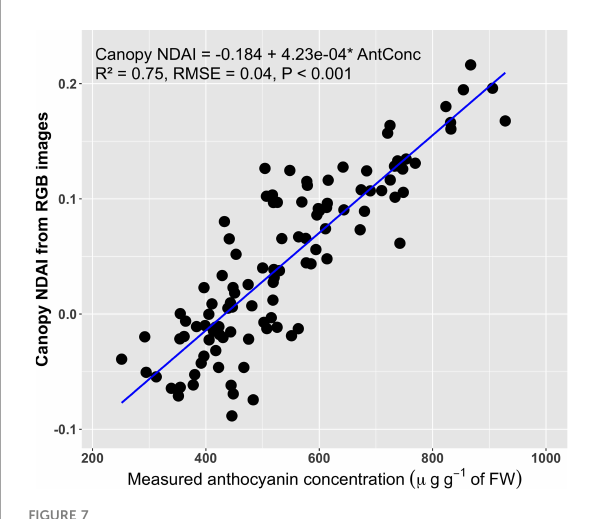
FIGURE 6 Correlation between the canopy normalized difference anthocyanin index (NDAI, averaged over the entire part of the canopy visible in the images) derived from multispectral images and the anthocyanin concentrations of the top layer of the canopy (n = 108). The blue line is the regression line.